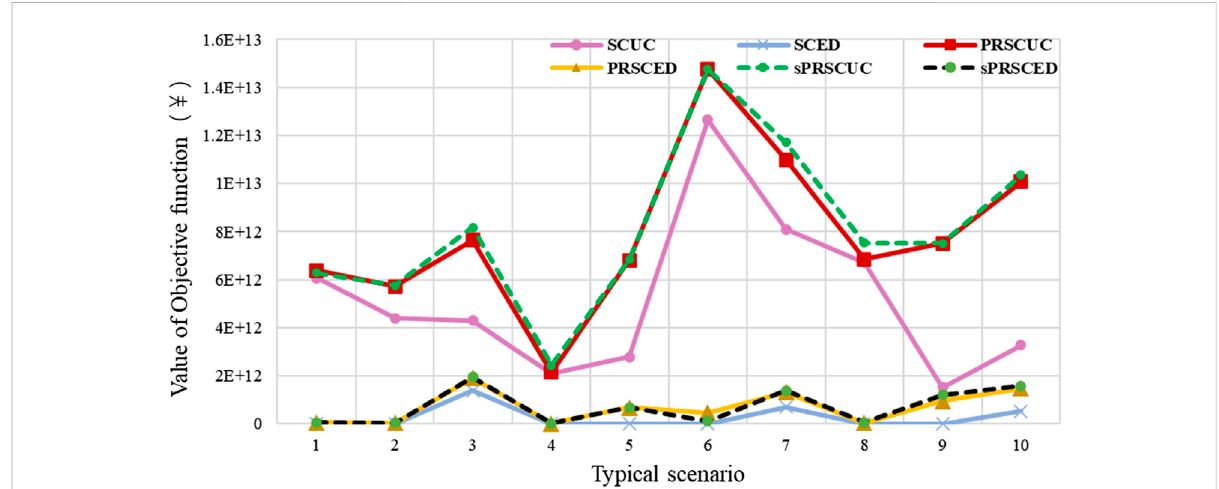
FIGURE 2 Comparison value of objective functions of different models under different typical